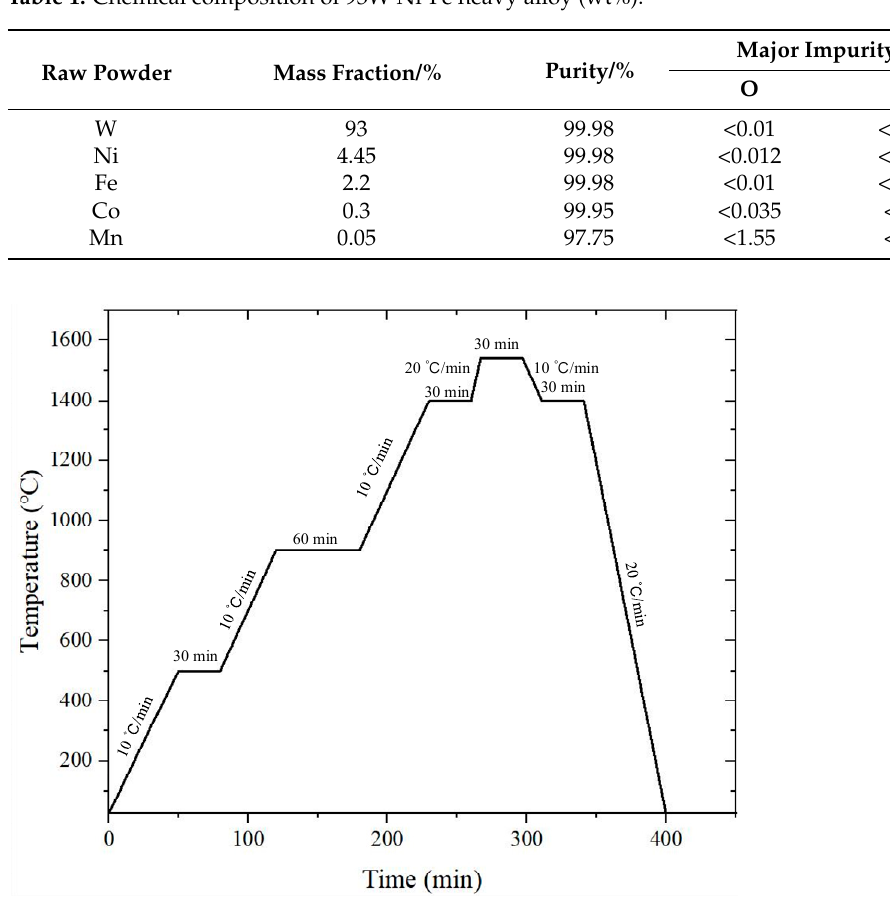
Table 1. Chemical composition of 93W-Ni-Fe heavy alloy (wt%).